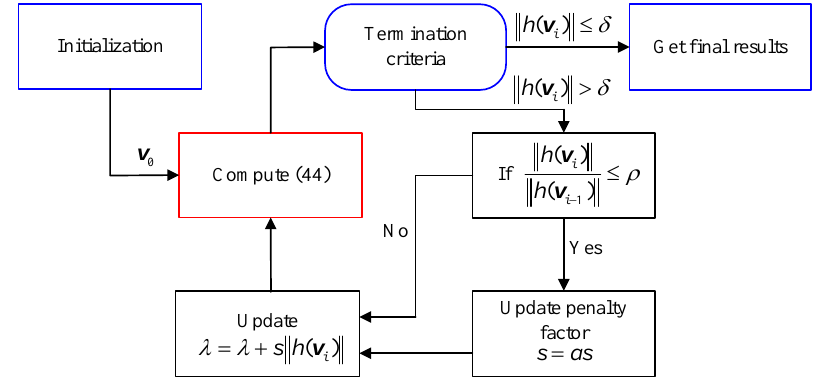
Figure 3. The flow diagram of the GLM algorithm.